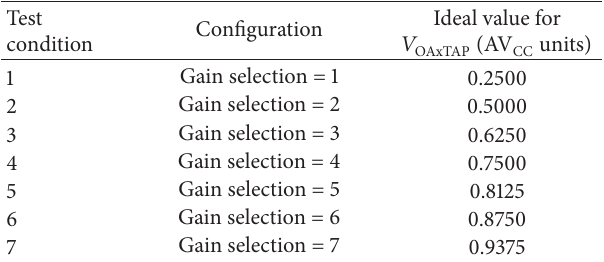
Table 3: Test conditions and expected values for the resistor